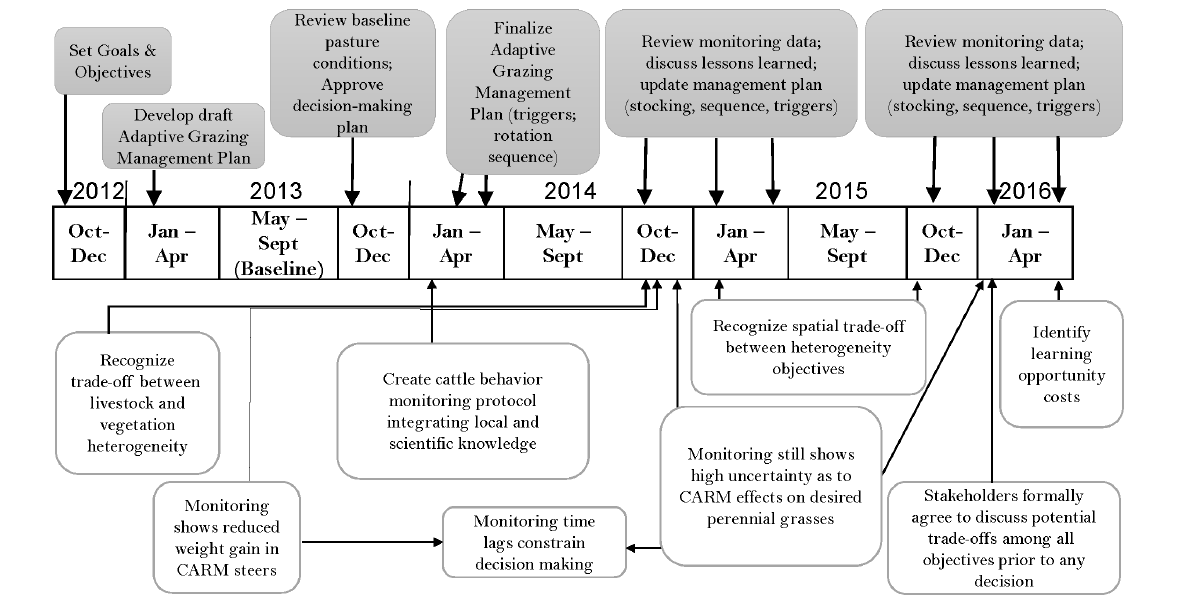
Fig. 3 . Timeline of decisions made by collaborative adaptive rangeland management (CARM) stakeholders (top boxes) relative to the timing of the grazing season (horizontal bar). The lightly shaded box (May-Sept 2013) indicates timing of pretreatment baseline monitoring when all pastures received the traditional, season-long grazing treatment. Dark shaded boxes indicate CARM grazing treatment implementation in 2014 and 2015. Boxes below the timeline indicate timing of each of the five complexities discussed in the Results section of the